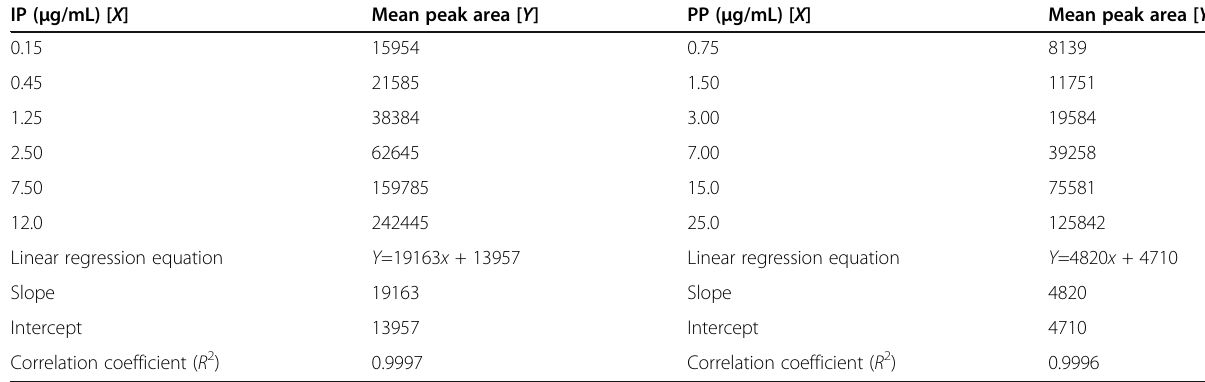
Table 2 Linearity of IP and